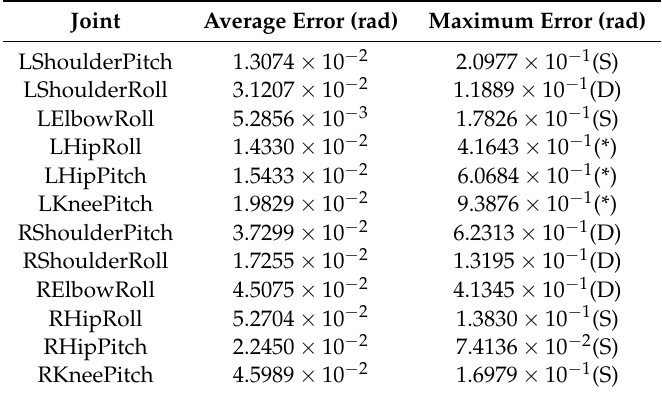
Table 1. Average and maximum errors of key joint angles. The errors between the robot and the human skeleton model were computed in each motion